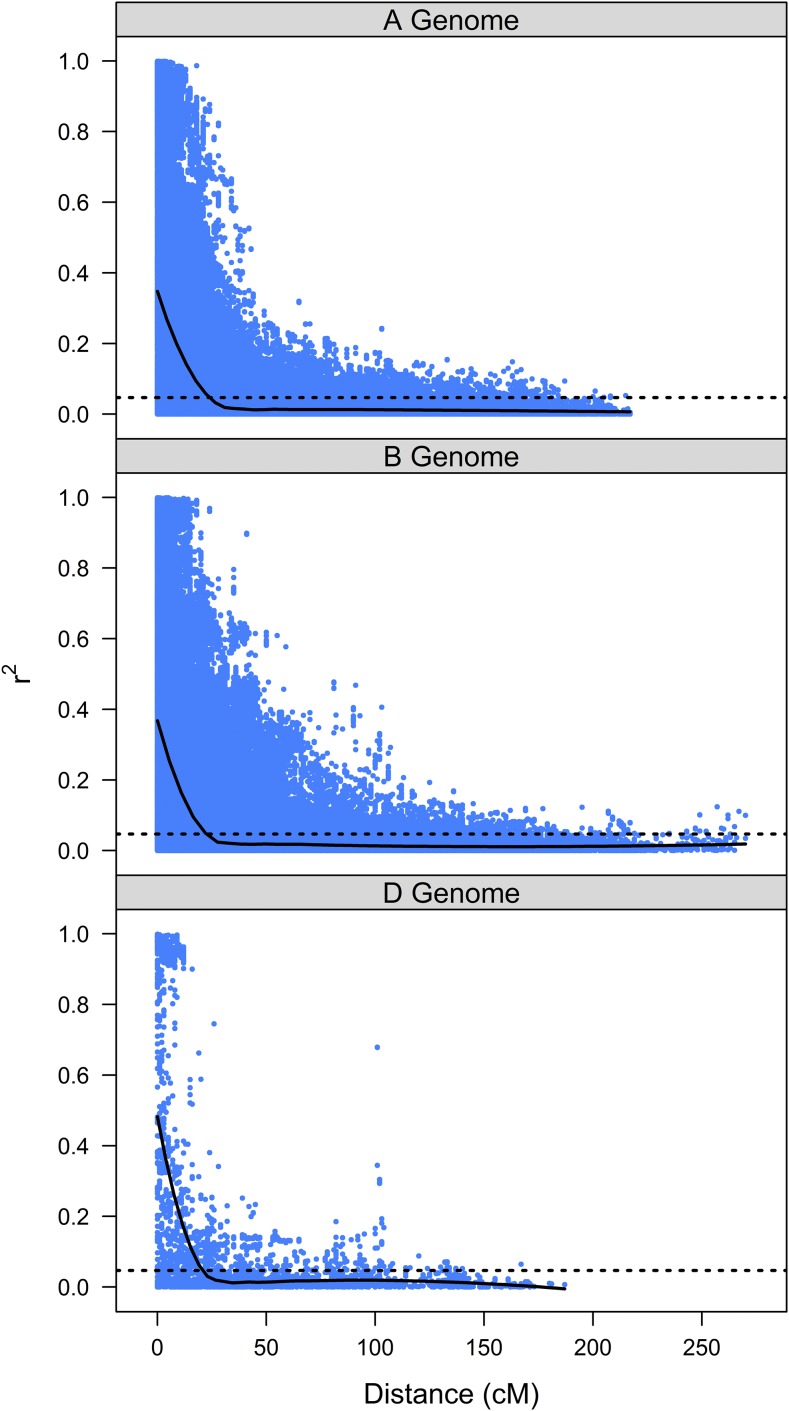
Pairwise LD estimates (r2) plotted against Euclidian pairwise marker distances for markers on the same consensus chromosome for the SNP marker set.